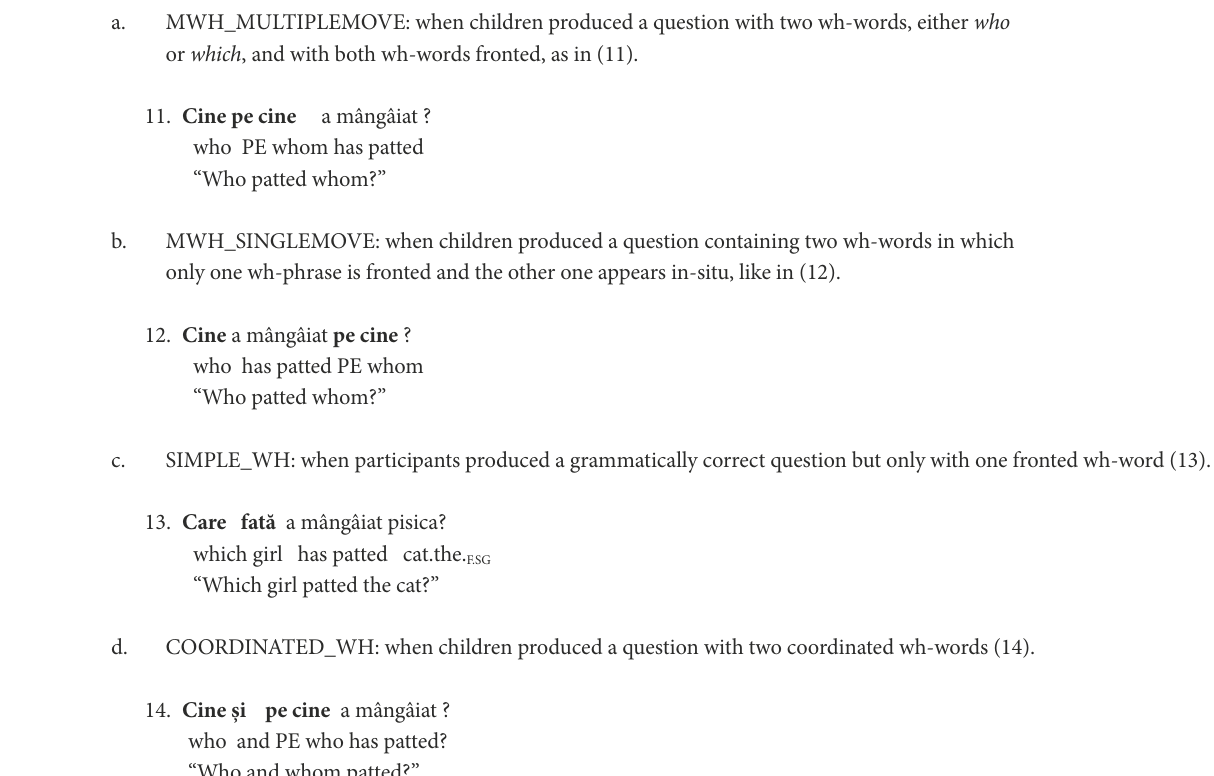
Figure 4. Monolingual children produce three types of questions at